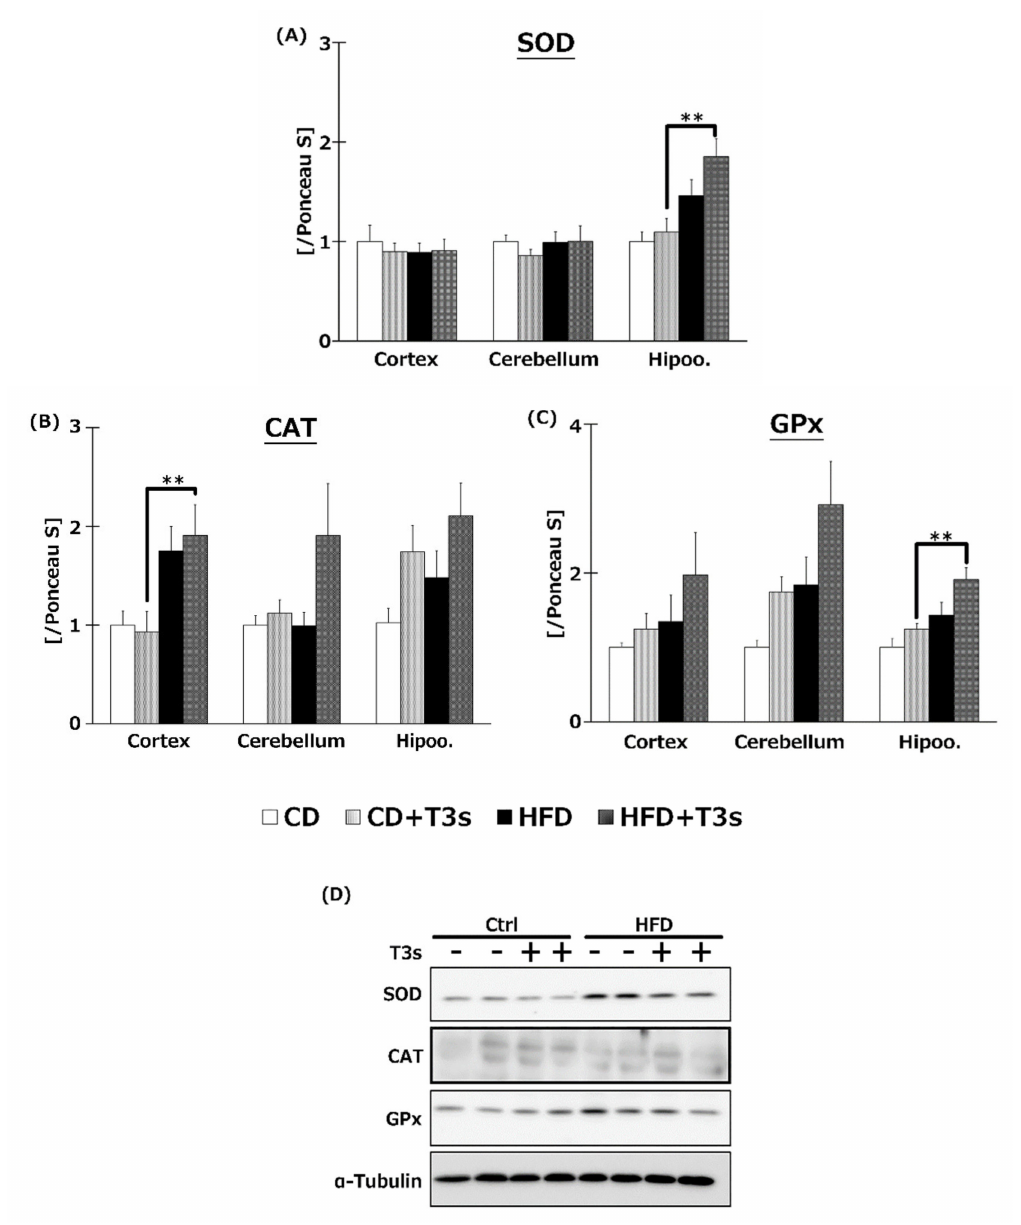
Figure 8. Western blotting analysis of SOD ( A ), CAT ( B ), and GPx ( C ) protein expression. Images of Western blots for each protein examined in hippocampus ( D ). CD = Control diet ( n = 10), CD + T3s = CD + T3 mix ( n = 10), HFD = high-fat diet ( n = 10), HFD + T3s = high-fat diet + T3-mix ( n = 10). Data are expressed as mean ± SE. Tukey–Kramer’s method: ** p <